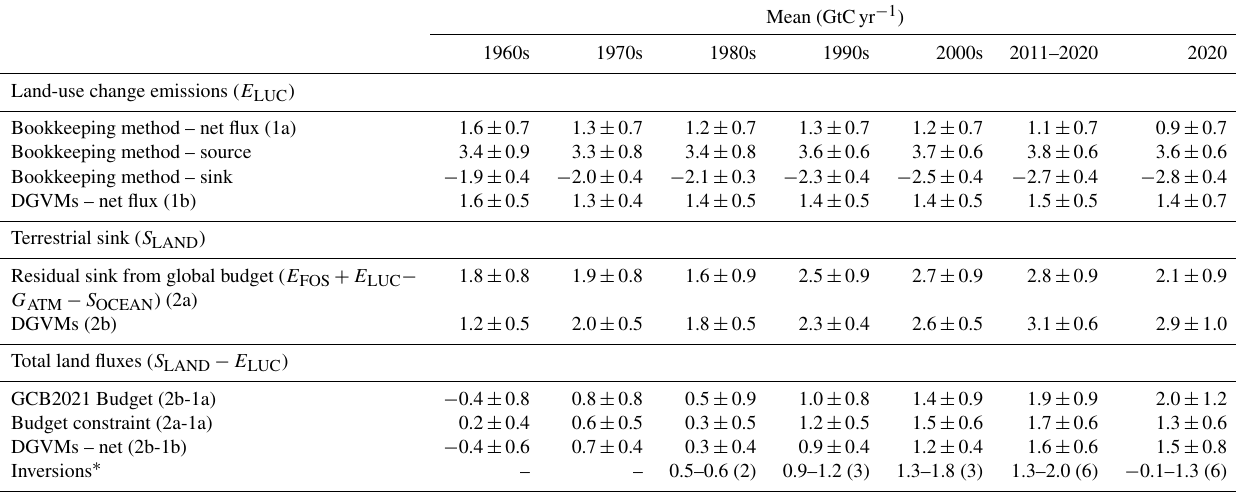
Table 5. Comparison of results from the bookkeeping method and budget residuals with results from the DGVMs and inverse estimates for different periods, the last decade, and the last year available. All values are in GtCyr − 1 . The DGVM uncertainties represent ± 1 σ of the decadal or annual (for 2020 only) estimates from the individual DGVMs: for the inverse models the range of available results is given. All values are rounded to the nearest 0.1GtC and therefore columns do not necessarily add to